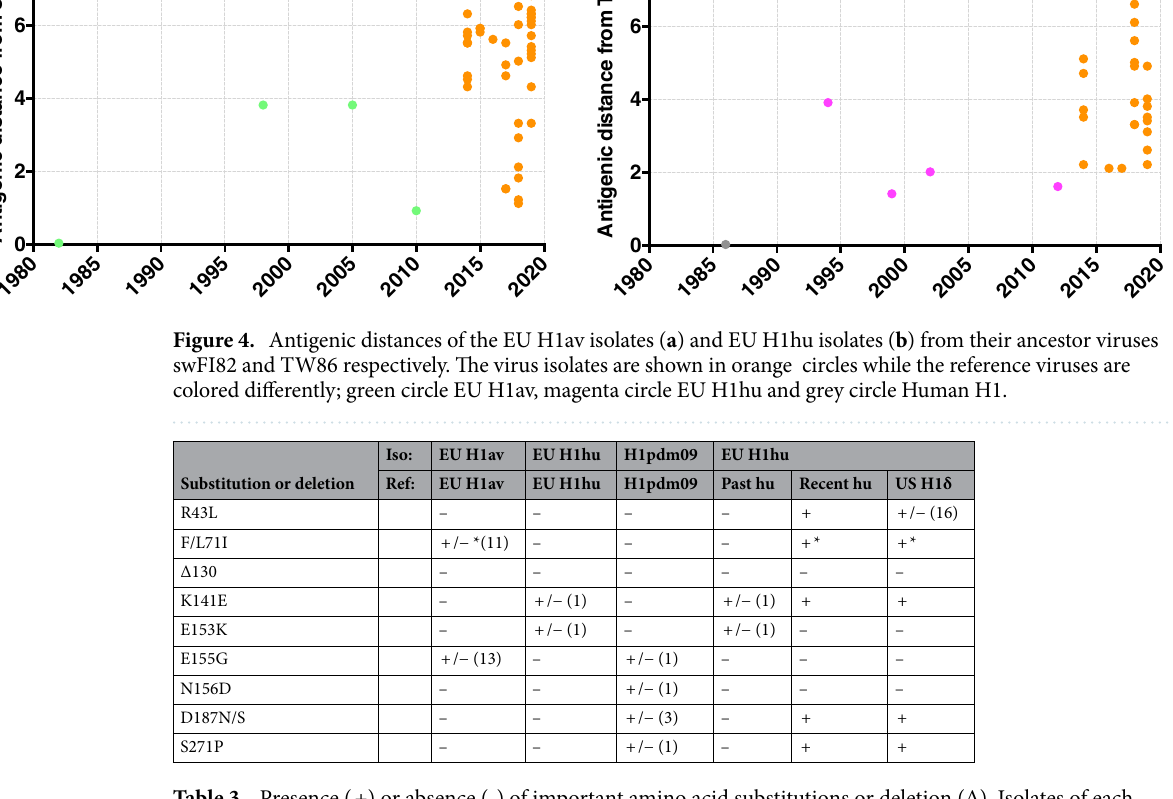
Table 3. Presence ( +) or absence (-) of important amino acid substitutions or deletion (Δ). Isolates of each lineage were compared with reference viruses belonging to the same lineage. Isolates belonging to the EU H1hu lineage were also compared with the US H1δ and past (TW86) and recent (NC99, BR07) human seasonal reference viruses due to their common origin. The symbol + /− is used where some isolates in the same lineage have the substitution while others do not. The number of isolates with the substitution are shown in brackets. In total, there were 42 EU H1av HA sequences, 21 EU H1hu and 5 H1pdm09 HA sequences.